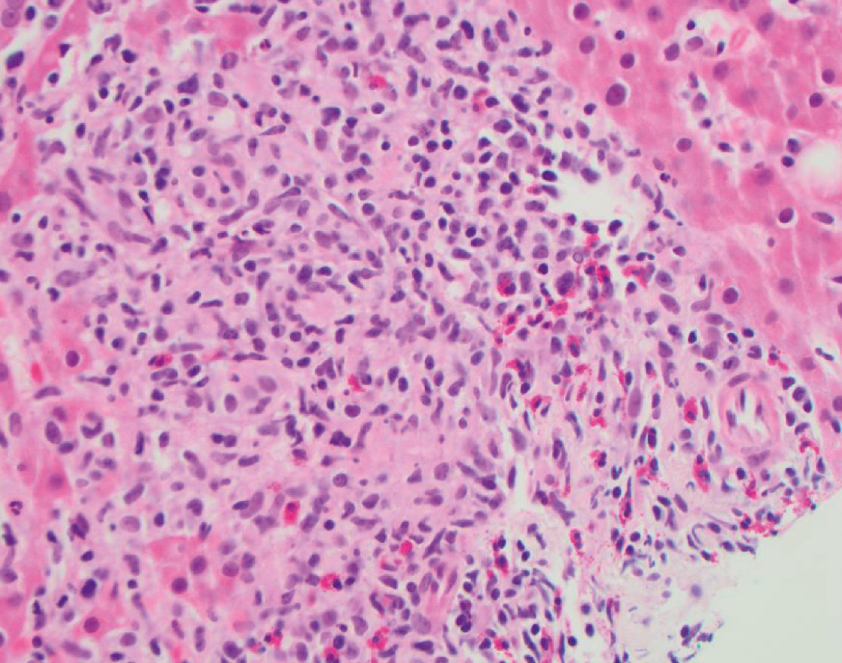
Figure 1: Liver portal triad is expanded by lymphocytes, eosinophils, and noncaseating granulomatous inflammation. H&E stain of liver tissue. No interface hepatitis or proliferating bile ductules. Original magnification, 400x.